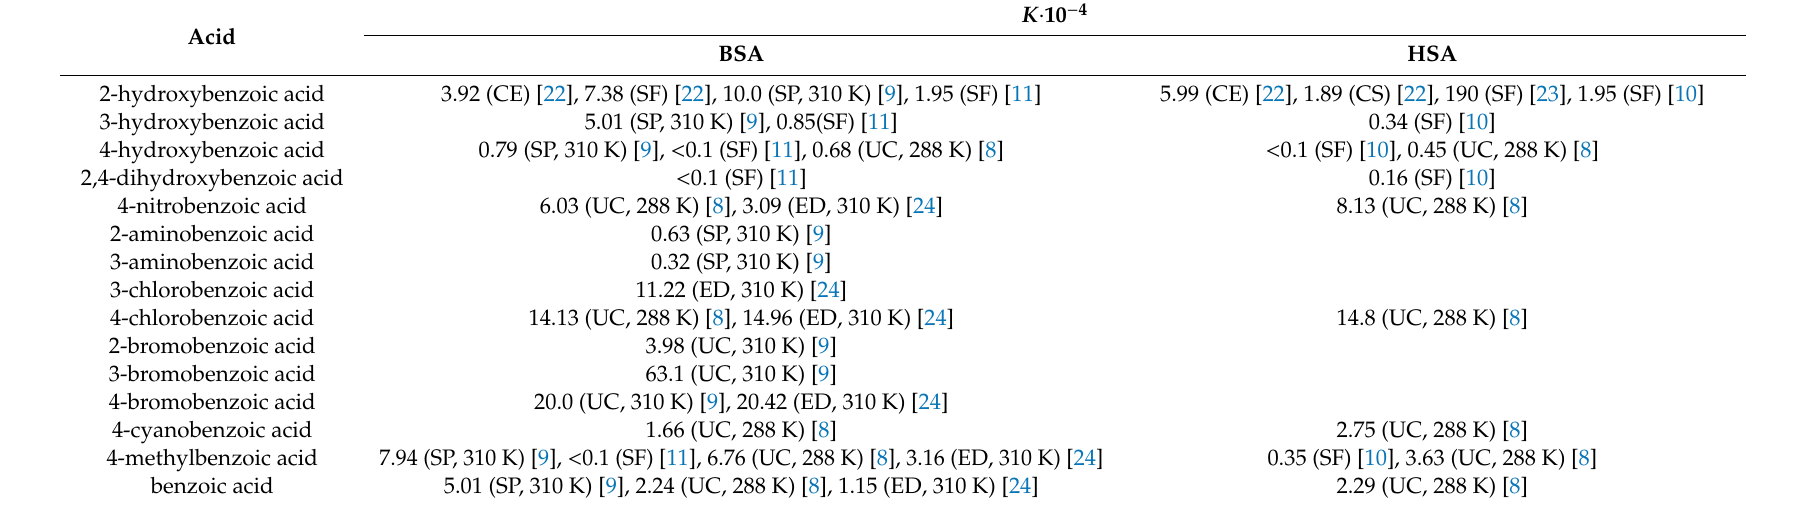
Table 2. Binding constants of the studied benzoic acids with BSA and human serum albumin (HSA) previously reported in literature (at 298 K if not otherwise mentioned). The letters in brackets indicate the method of measurement (CE—a ffi nity capillary electrophoresis, SP—spectrophotometry,